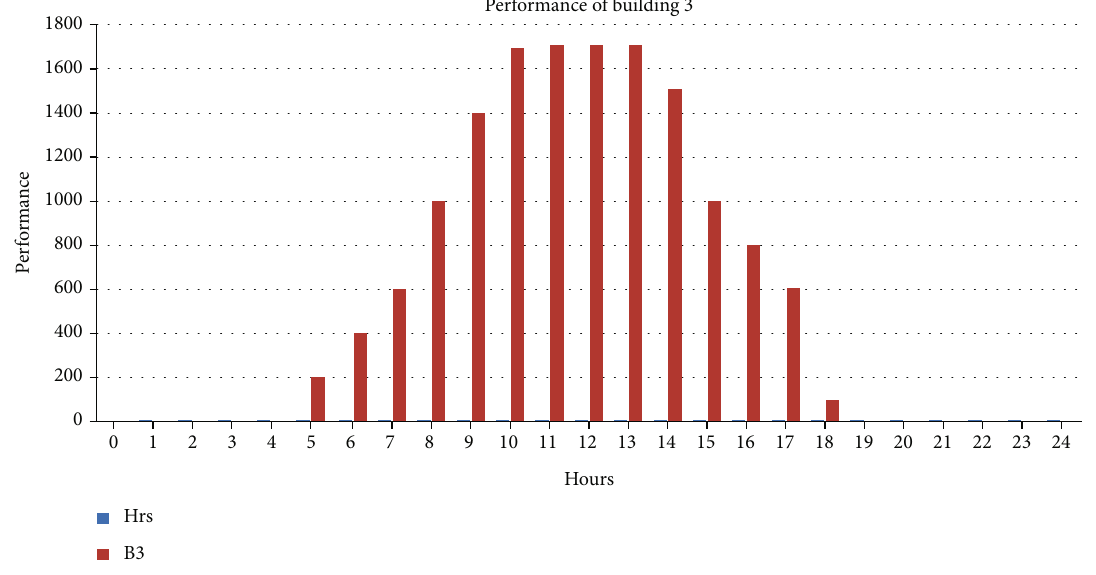
Figure 12: Performance of building 3 on hourly